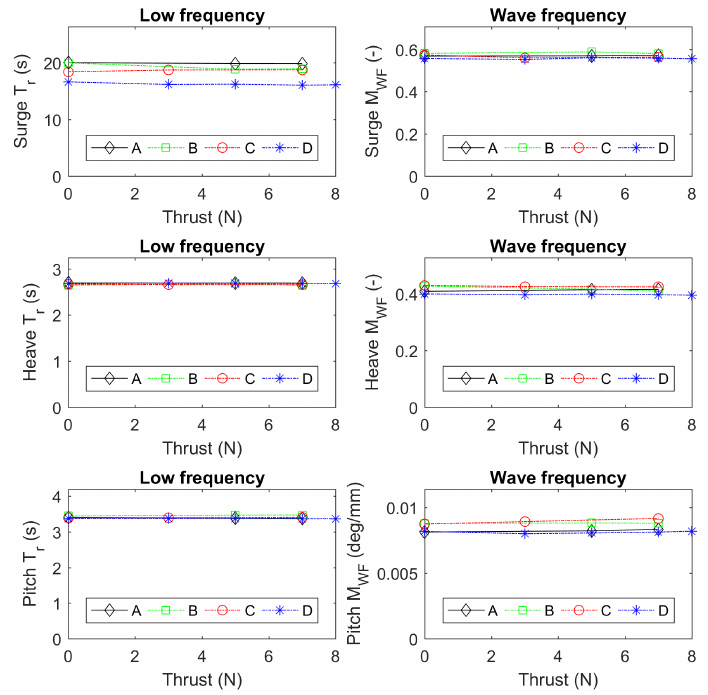
Figure 23. Metrics T r (left column) and M WF (right column) for JONSWAP T p = 1.81 s, H s = 10 cm per facility for surge (top row), heave (middle row), and pitch (bottom row) at thrust levels of 0, 3, 5, 7, and 8 N (8 N applied at facility D